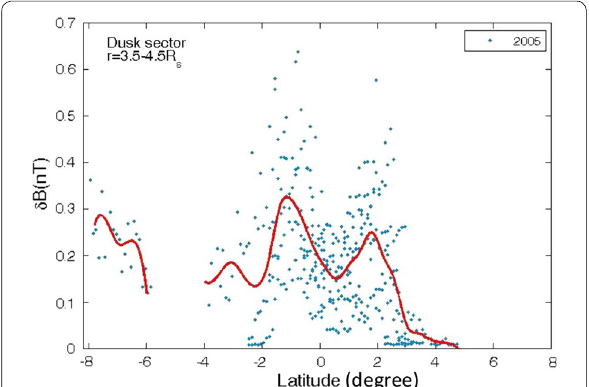
Fig. 8 The averaged perturbed magnetic field amplitude δB in the radial distance range of 3.5–4.5 R S versus latitude for the dusk sector collected from the 2005 data. Each point represents the averaged δB within a small region of Δ θ